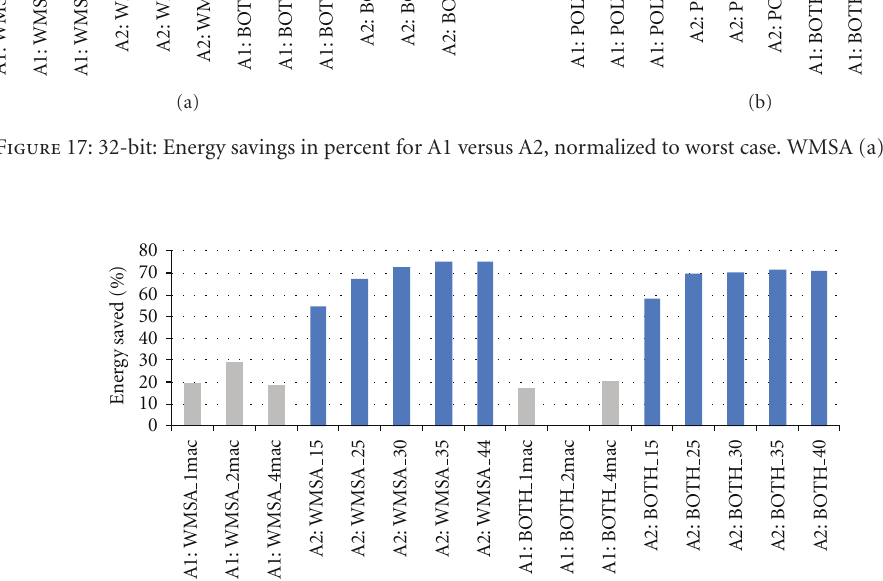
01020304050607080